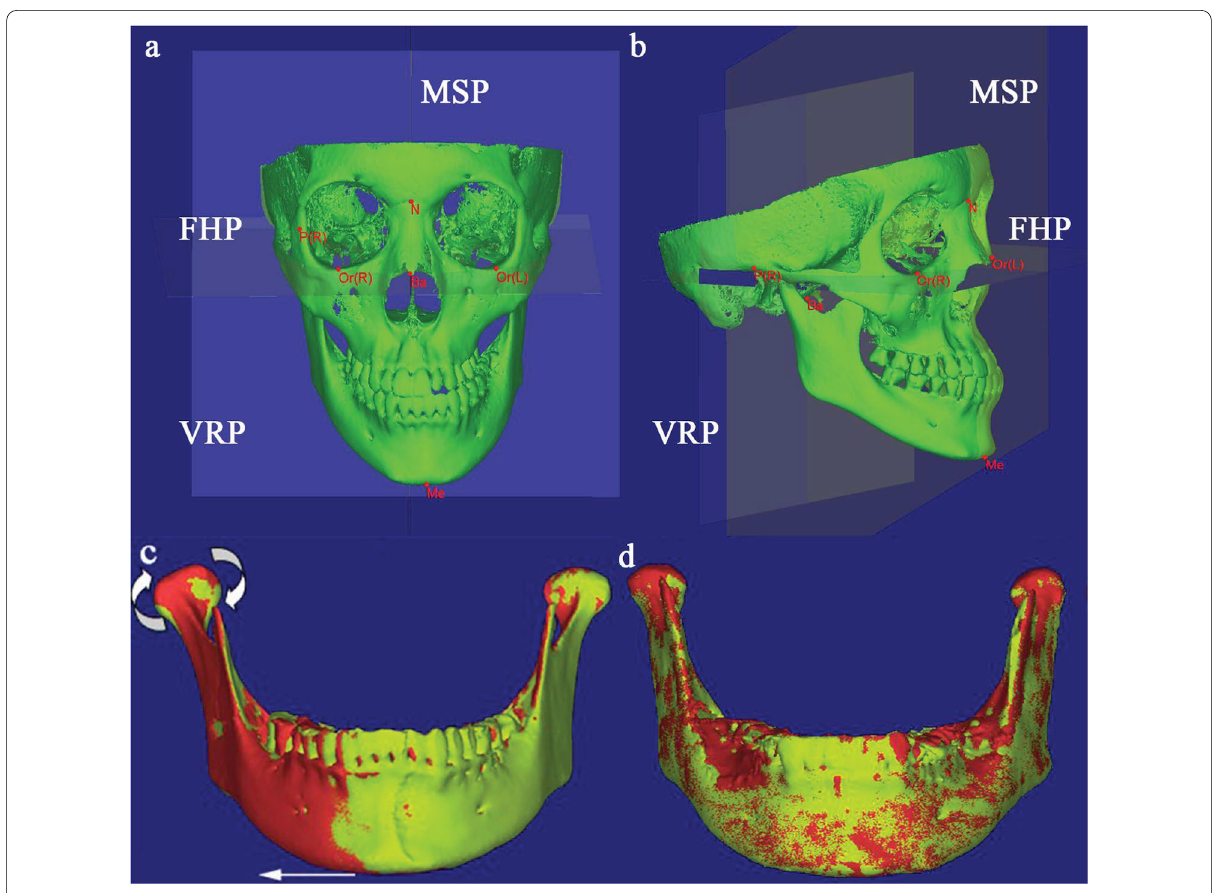
Fig.2 The deviated side of the mandible is on the patient’s own left side. Three reference planes in a front view, b side view; 3D reconstruction model, the red one represents T2 and the yellow one represents T1: c changes of mandibular position after cranial base registration, d morphological changes after mandibular